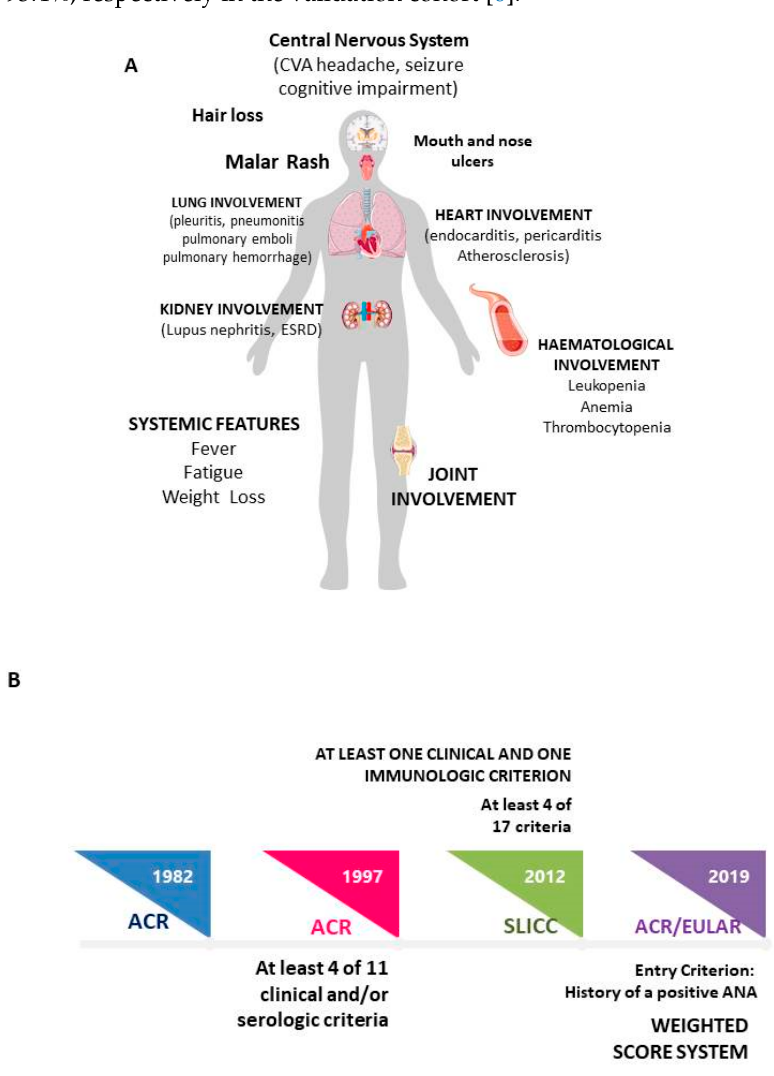
Figure 1. ( A ) Systemic Lupus Erythematosus: main clinical manifestations; ( B ) Classification criteria timeline.